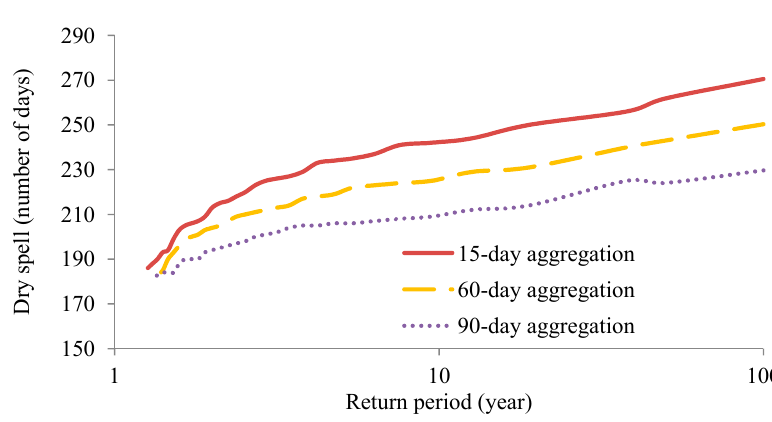
Figure A9. Hydrological dry spell–duration–frequency